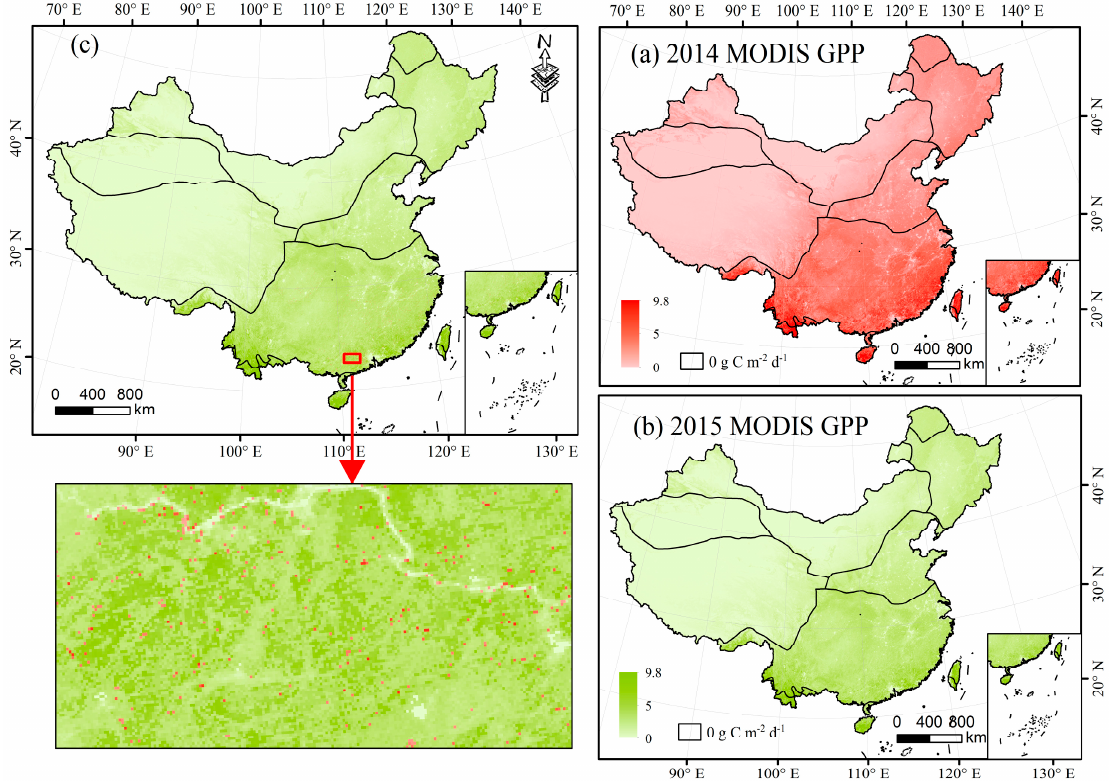
Figure 7. ( a ) and ( b ) represent the spatial patterns of MODIS GPP in 2014 and 2015, respectively. ( c ) provides an overlay of ( a ) and ( b ), with the red box encompassing an area where numerous zero values for GPP were obtained in